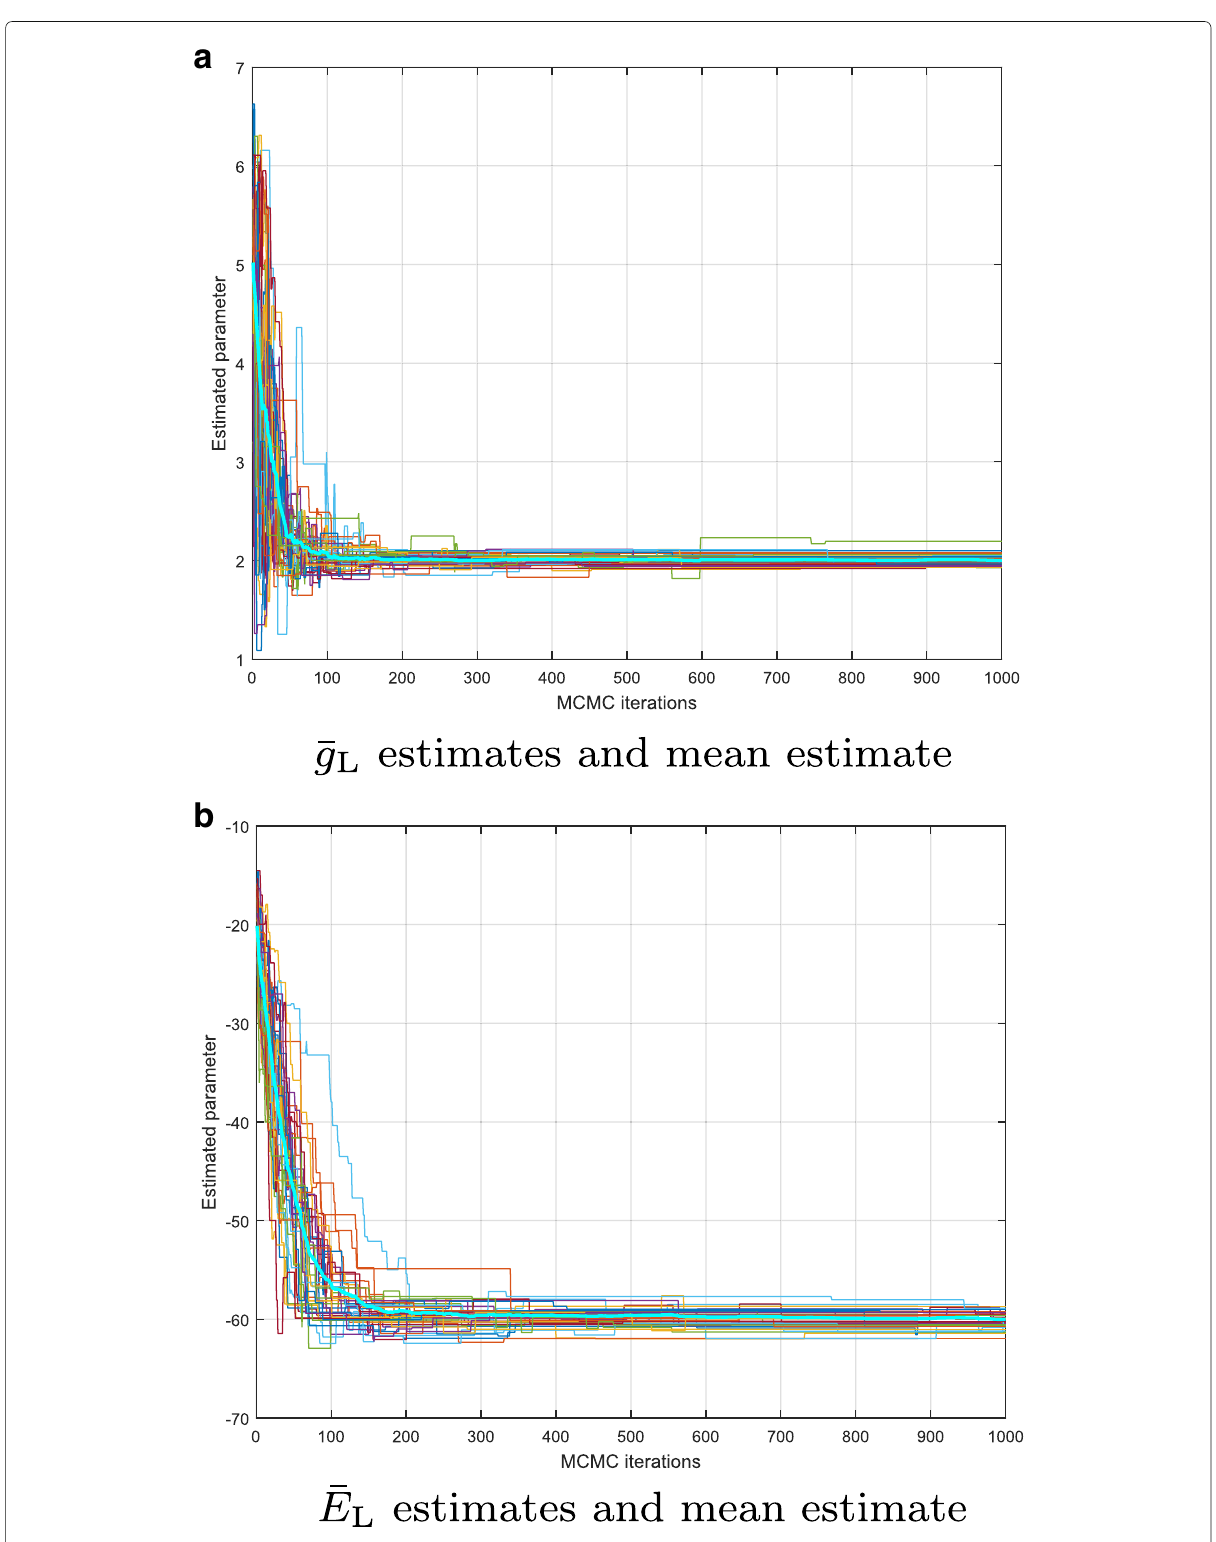
Fig. 7 Parameter estimation performance of the proposed PMCMC algorithm. a Top plot shows results for ¯ g L = 2 estimation and ( b ) bottom plot for E L = − 60. Both plots show superimposed independent realizations together the average estimate of the parameter (thicker